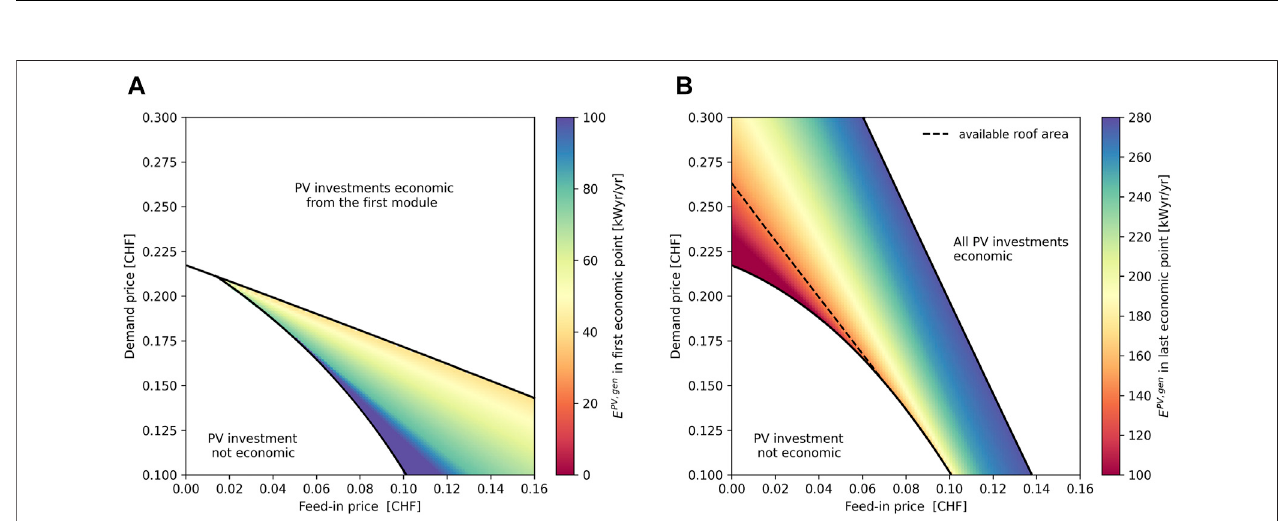
FIGURE 8 | Variation of the PV yearly generation to achieve break-even as a function of feed-in and demand prices. (A) First break-even point (B1); (B) last break- even point (B2 or A) in Figure 7 .